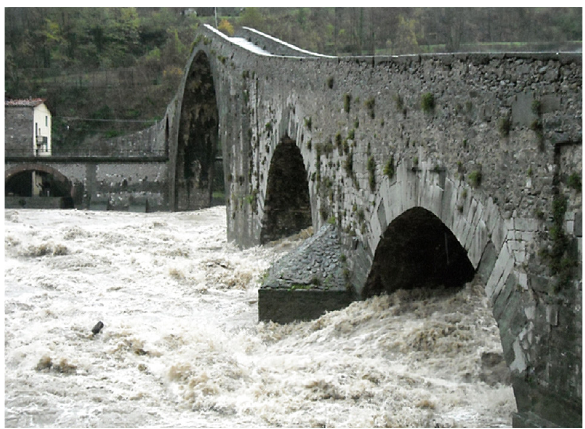
Figure 2. The Serchio River in full spate, from the downstream side.